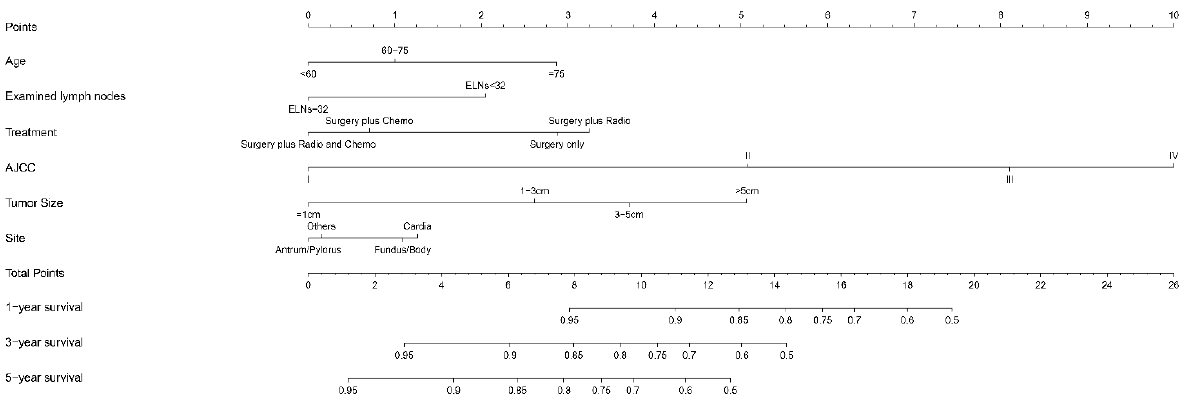
Figure 3. Nomogram based on examined lymph nodes for predicting survival outcome in patients with gastric signet ring cell carcinoma.